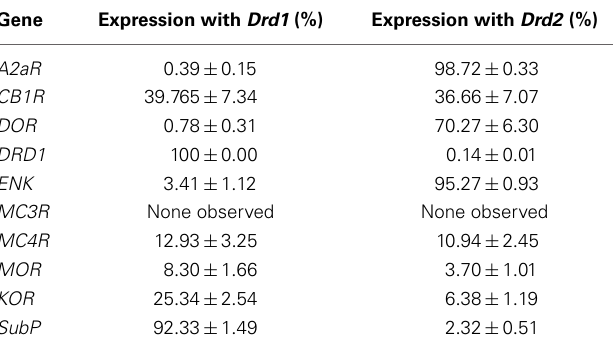
Table 2 | Percentage of coexpression of all investigated mRNAs with Drd1 or Drd2